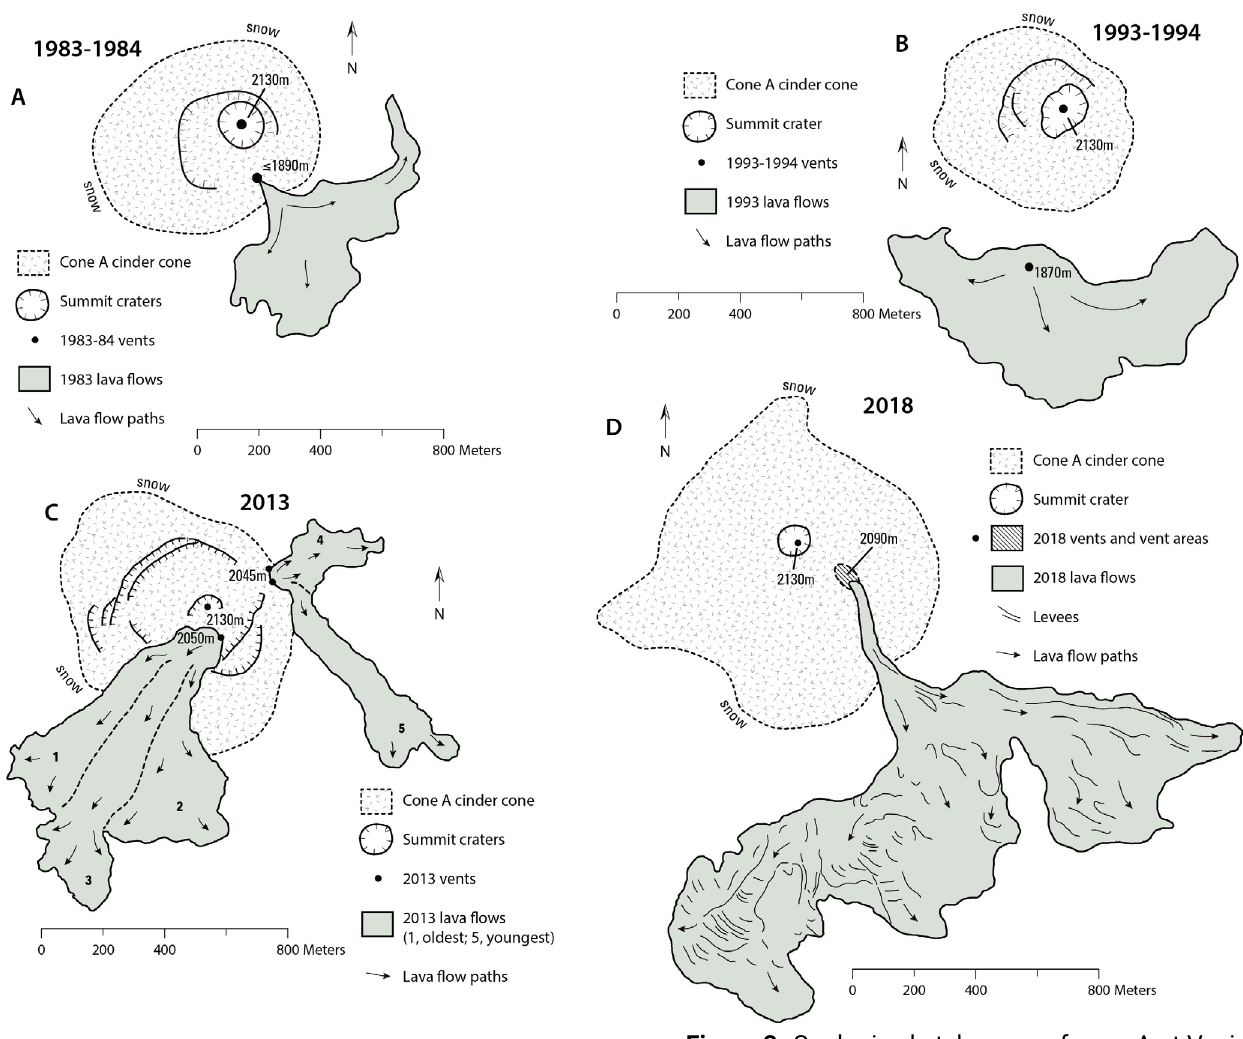
Figure 3: Geologic sketch maps of cone A at Veni- aminof Volcano showing extent of lava flows and eruptive vents. The locations and altitudes of vents indicated on each map are approximate. Eleva- tion data obtained from 2019 Alaska IfSAR data ( https://elevation.alaska.gov ). The dashed line outlining cone A on each map is the contact with the surrounding snow and glacier ice. [A] Map of cone A showing lava flows and vents associated with the 1983–1984 eruption. Base is vertical aerial photograph acquired in August 1983. [B] Map of cone A showing lava flows and vents associated with the 1993–1994 eruption. Base is vertical aerial photograph acquired in August 1993. [C] Map of cone A showing lava flows and vents associated with the 2013 eruption. Base is WorldView-1 satel- lite image. [D] Map of cone A showing lava flows and vents associated with the 2018 eruption. Base is WorldView-2 satellite image. [E] Map of cone A showing lava flows and approximate vent loca- tions associated with the 2021 eruption. Base is WorldView-3 satellite